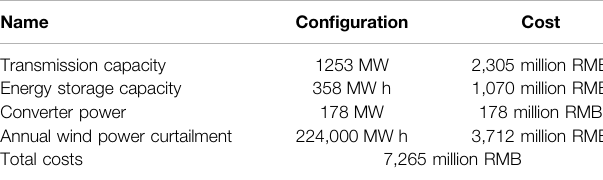
TABLE 2 | Coordination and optimization results of energy storage and transmission channels (continuous